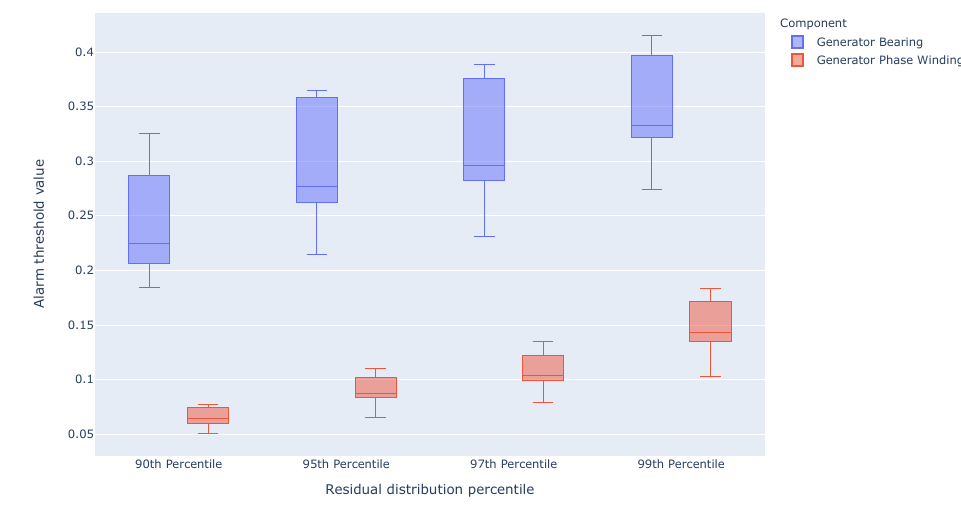
Figure 8. Variation in alarm threshold between turbines after